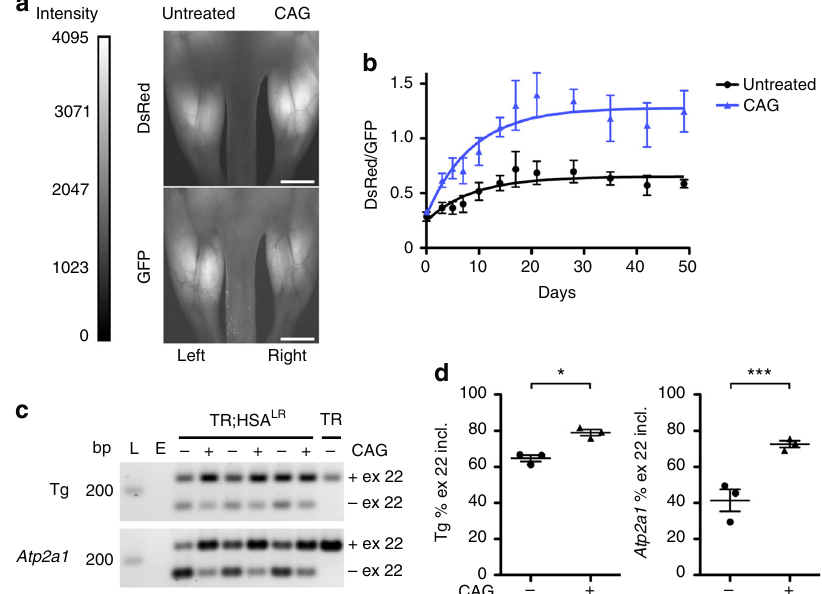
Fig. 3 Imaging therapeutic antisense oligonucleotide drug activity in vivo. We administered a CAG repeat morpholino (CAG) ASO designed to bind and neutralize the pathogenic effects of expanded CUG repeat RNA 7 by intramuscular injection of the right gastrocnemius in TR;HSA LR mice ( N = 3). The left gastrocnemius was injected with saline or was untreated. a Representative images of quantitative in vivo DsRed and GFP fl uorescence under general anesthesia 28 days after injection of the CAG ASO. Fluorescence intensity range = 0 – 4095 grayscale units. Bars = 4 mm. b Quantitative DsRed/GFP fl uorescence ratios in muscles of untreated (black circles) and CAG ASO-treated (blue triangles) mice by serial in vivo imaging. Error bars indicate mean ± s.e.m. Non-linear regression. c RT-PCR analysis of transgene and endogenous Atp2a1 exon 22 in untreated ( − ) or CAG ASO-treated ( + ) muscles 49 days after injection. E empty lane, L DNA ladder, bp base pairs. d Quantitation of splicing results in c . Error bars indicate mean ± s.e.m. *** P = 0.0002; * P = mean difference 14.2, 95% CI of difference 1.0 – 27.5 (two-way ANOVA). These results are representative of four independent